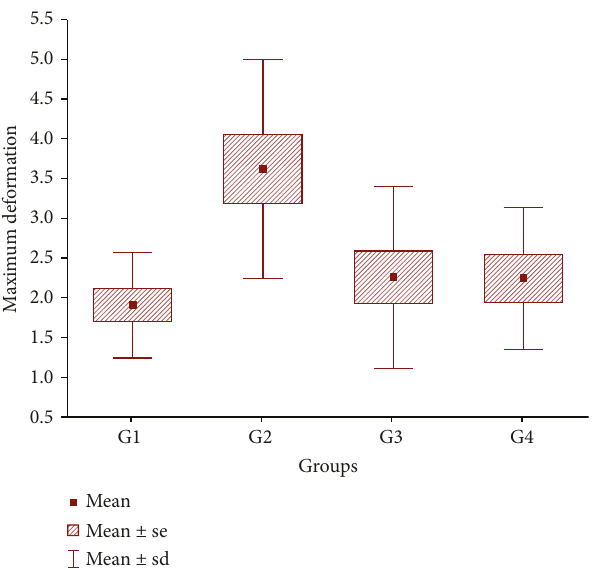
Figure 2: A histogram showing maximum deformation, which is signi fi cantly higher in the PRP group. G1 = SC ; G2 = PRP ; G3 = SC +PRP; G4 = ET . PRP: platelet-rich plasma; SC: stem cell: sd: standard deviation; se: standard error.